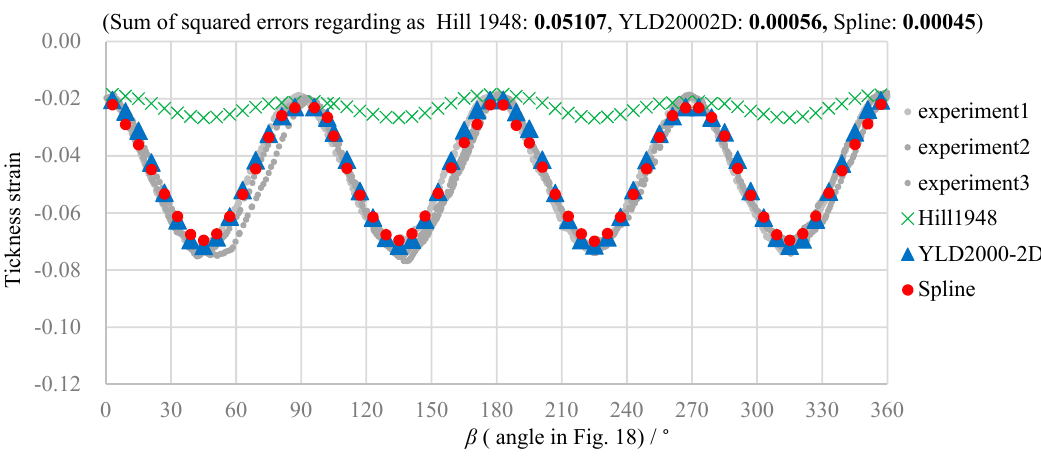
Figure 21. Comparison of thickness strain distributions on circle 3 in experimental condition A.